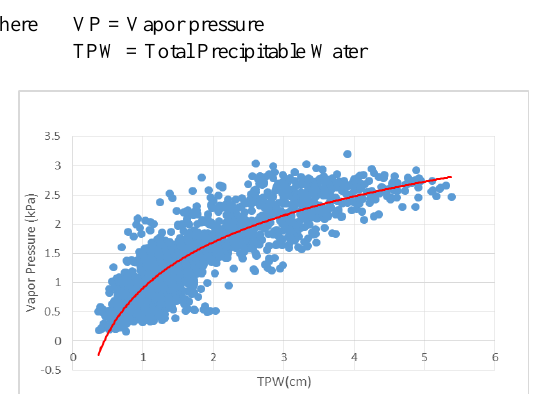
Figure3. Scatterplots of TPW against VP